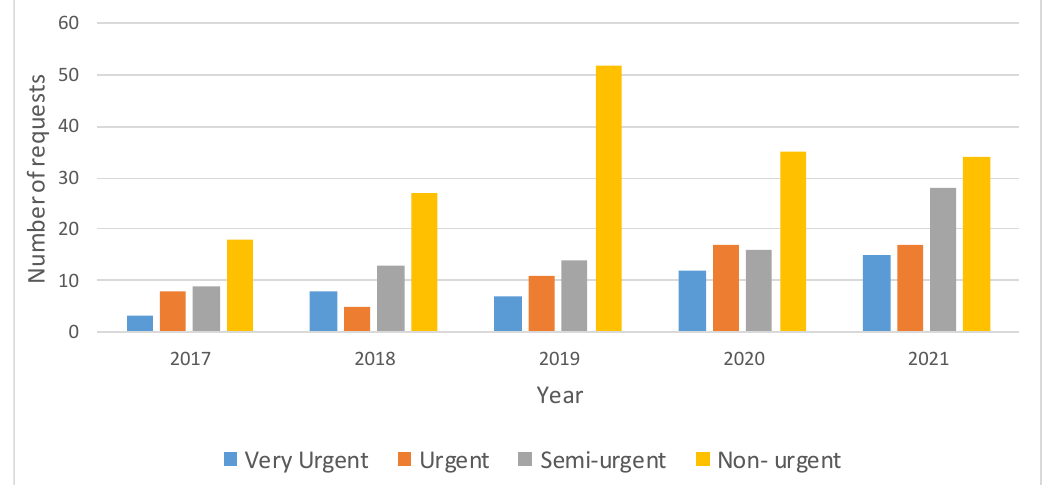
Figure 8. Evolution of the urgency of requests registered on the intranet for 3D printing models at Cruces Hospital. It shows the requests in complete years from 2017 to 2021. The 3 cases from 2016 were removed, as they are not considered representative.